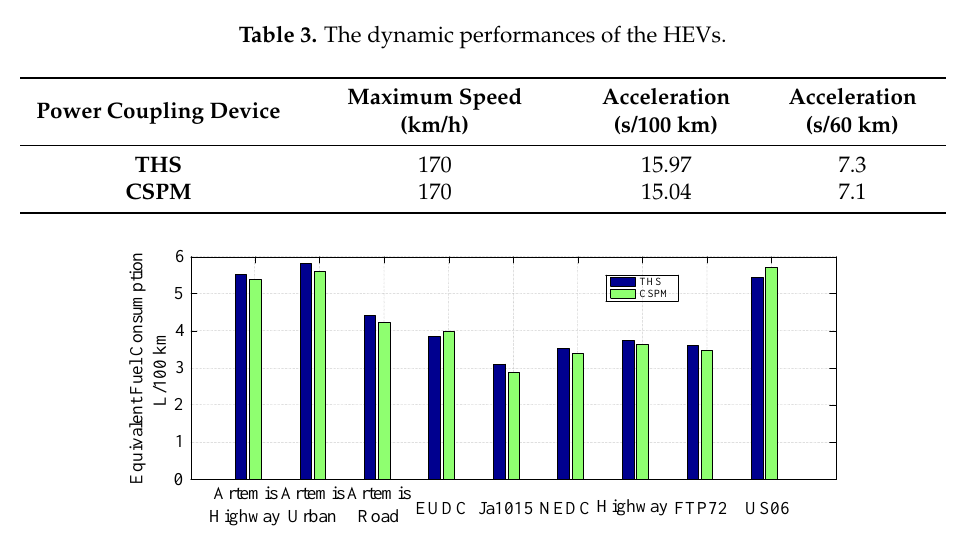
Figure 6. The comparison of fuel economy between THS and the CSPM motor.